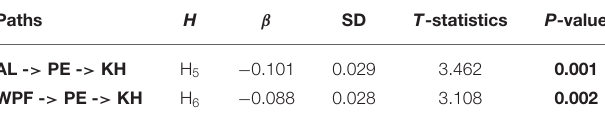
TABLE 5 | Indirect effects. Paths H β SD T -statistics P